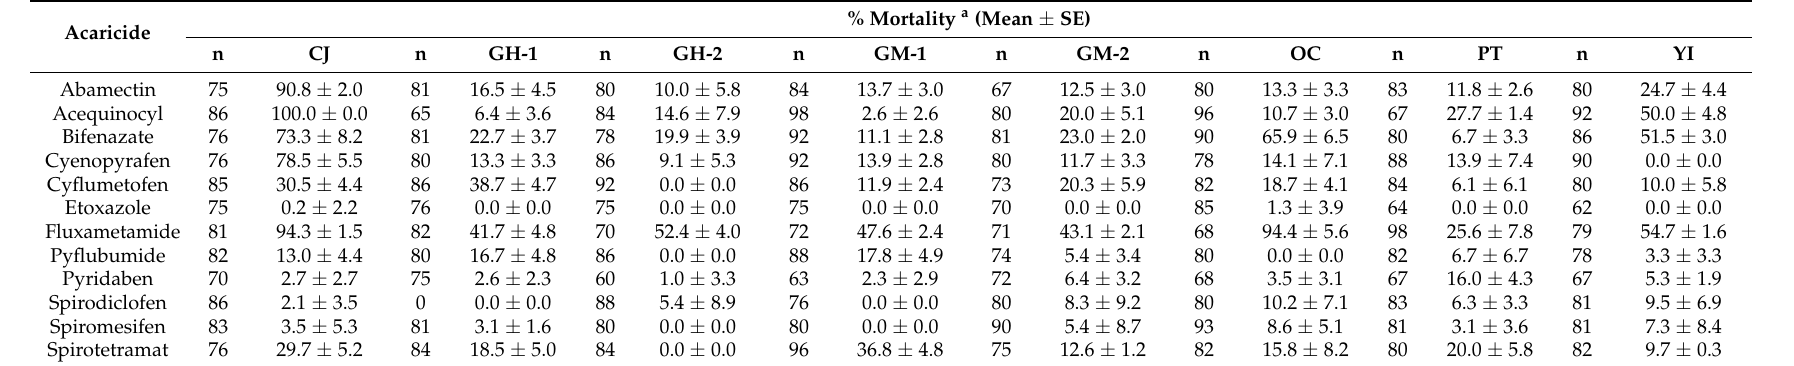
Table 7. Mortality of T. urticae adults of eight field populations in response to 12